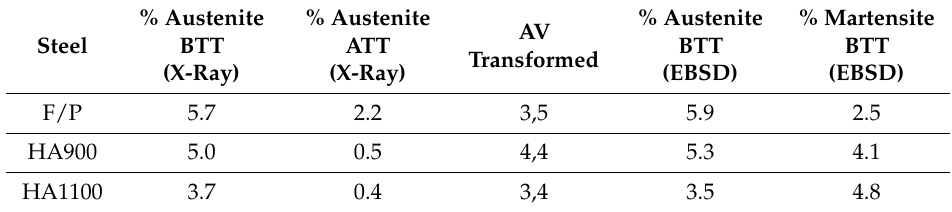
Table 2. Austenite and martensite volume fraction obtained by X-Ray and EBSD.